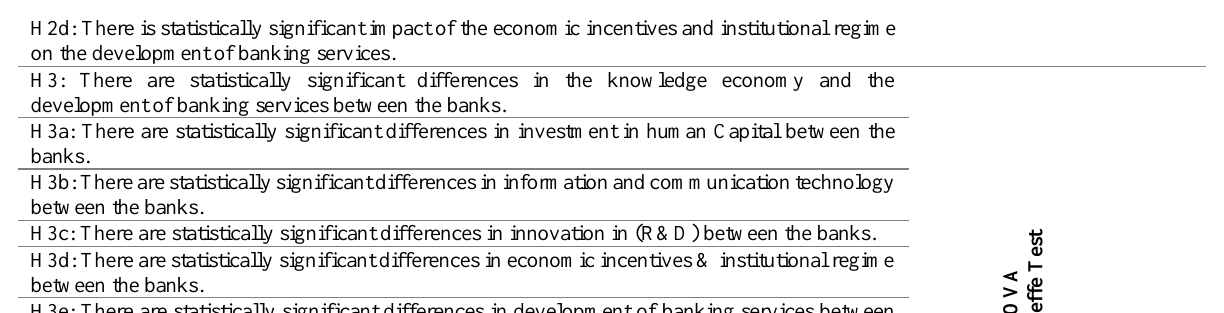
Table Cont’d H2d: There is statistically significant impact of the economic incentives and institutional regime on the development of banking services.